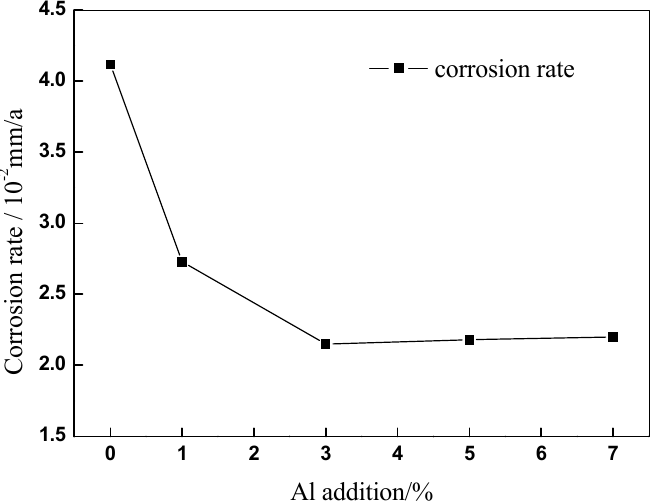
Figure 8. Effect of Al content on corrosion rate of Cu-7Ni- x Al-1Fe-1Mn alloy after immersing in artificial seawater for 10 days.